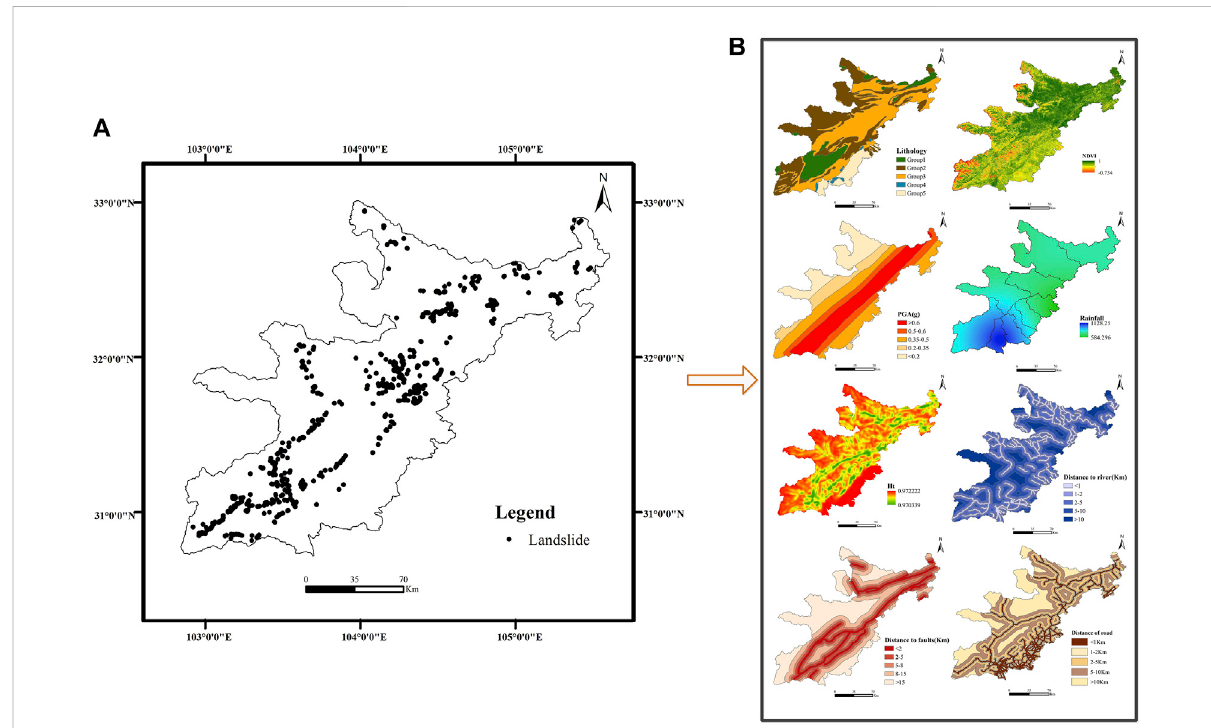
FIGURE 1 Overview of the research area. (A) shows the distribution of landslide points in the study area, and (B) shows the distribution of the size of eight in fl uencing factors in the study area.